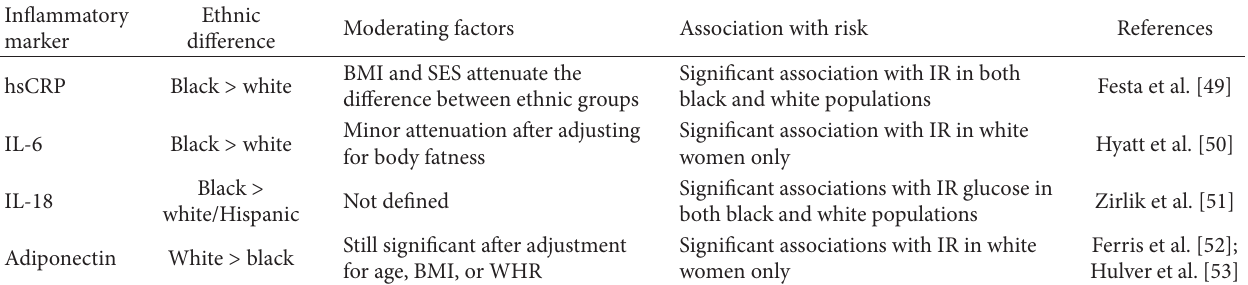
T 2: Ethnic differences in the relationship between circulating in�ammatory markers and insulin